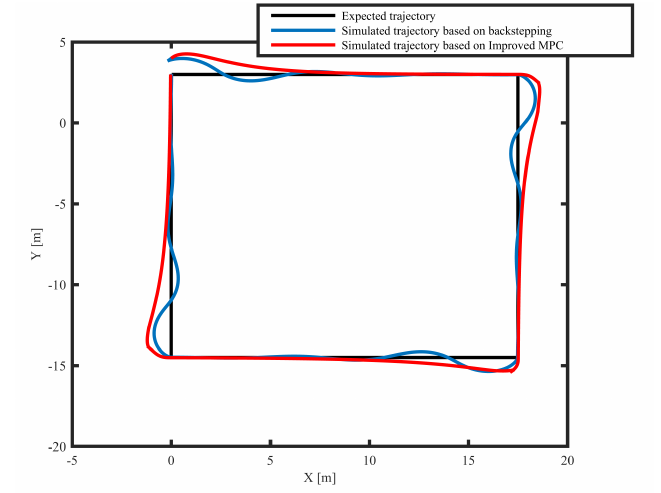
Figure 15. The simulation results compared with the backstepping method in square tracking.